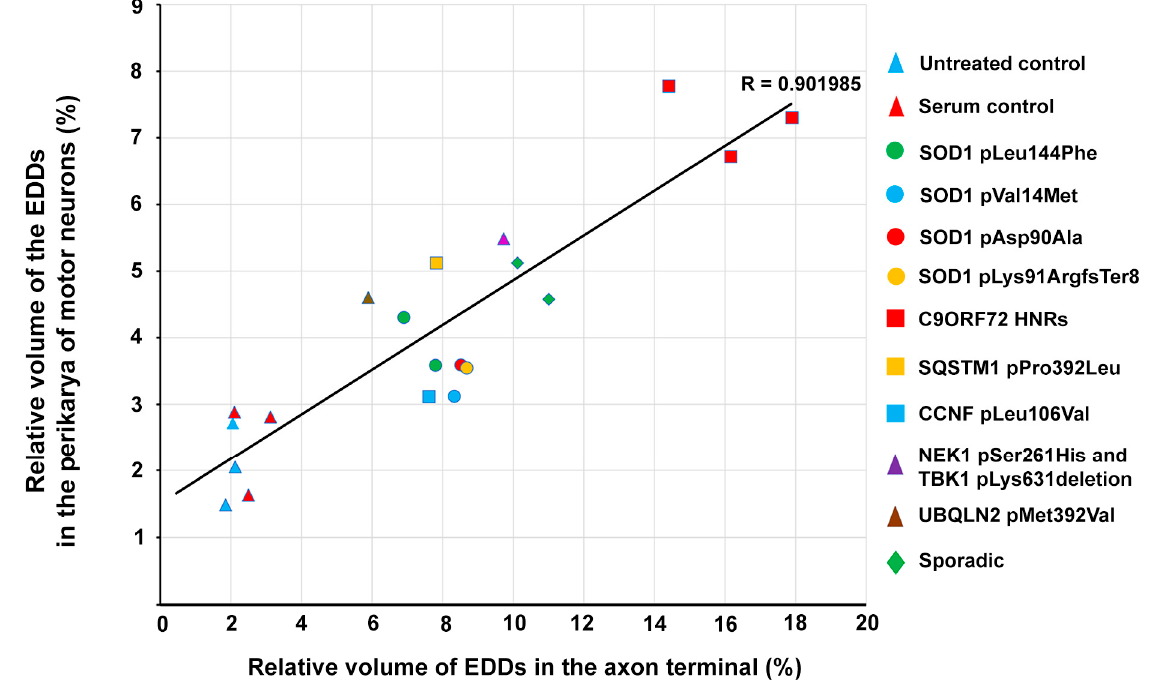
Figure 7. Volume densities of the electron-dense deposits from the two anatomical regions of the spinal motor neurons (MNs) of injected mice were pooled to patients and plotted in such a way that (except for the untreated animals) each symbol represented a patient who served as a serum donor. Passive transfer of amyotrophic lateral sclerosis sera resulted in a mutual increase in calcium levels in the central and peripheral parts of the MNs. This observation was corroborated by the analysis of the fitted linear model, where the correlation coefficient (R) was 0.902, representing a strong correlation between the examined variables.